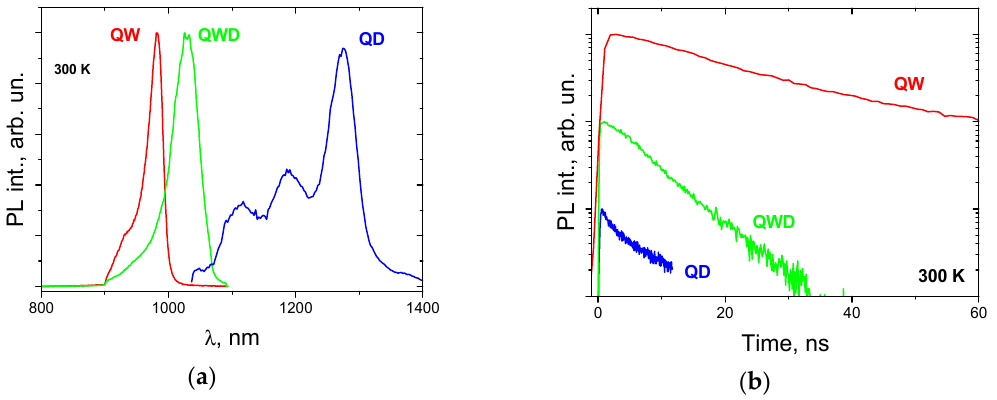
Figure 9. Normalized PL spectra ( a ) and temporal evolution of PL signal at its spectral maximum ( b ) for quantum dots (blue), quantum well-dots (green), and quantum well (red).